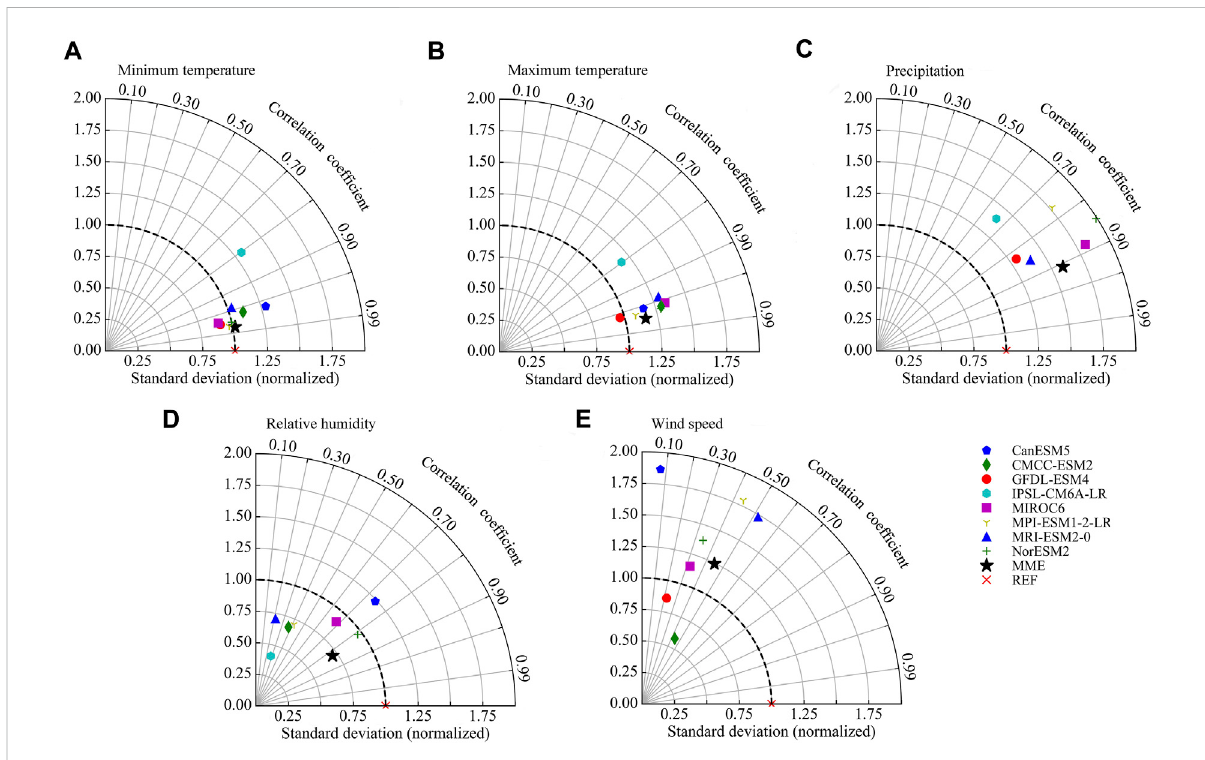
FIGURE 4 Taylor diagram for the monthly values of fi ve climatic factors ( (A) average minimum temperature (B) average maximum temperature (C) precipitation (D) average relative humidity and (E) average wind speed) between historical simulations of 8 models and observed data (REF) from 1976 to